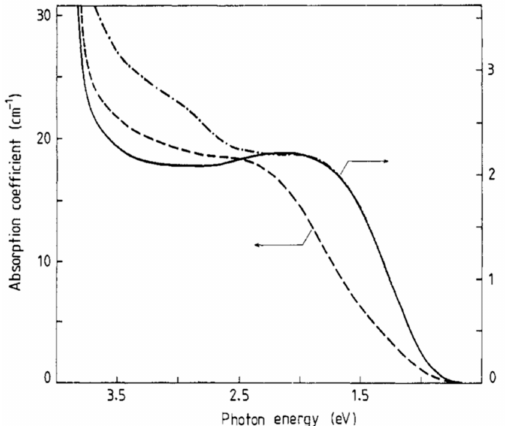
Figure 1. Reduction-induced absorption in a near-sLN sample covered by Pt foil (full line), a similar uncovered sample (dash-dotted), and a cLN sample (dashed line), measured at RT. The vacuum-reduction temperature was 880 ◦ C (Reprinted with permission from [33]. Copyright 2021 IOP